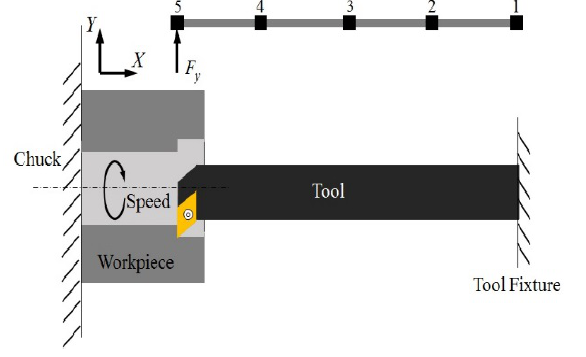
Figure 3. Finite element model of the boring bar [37] Figure 4. Setup of the impact hammer test